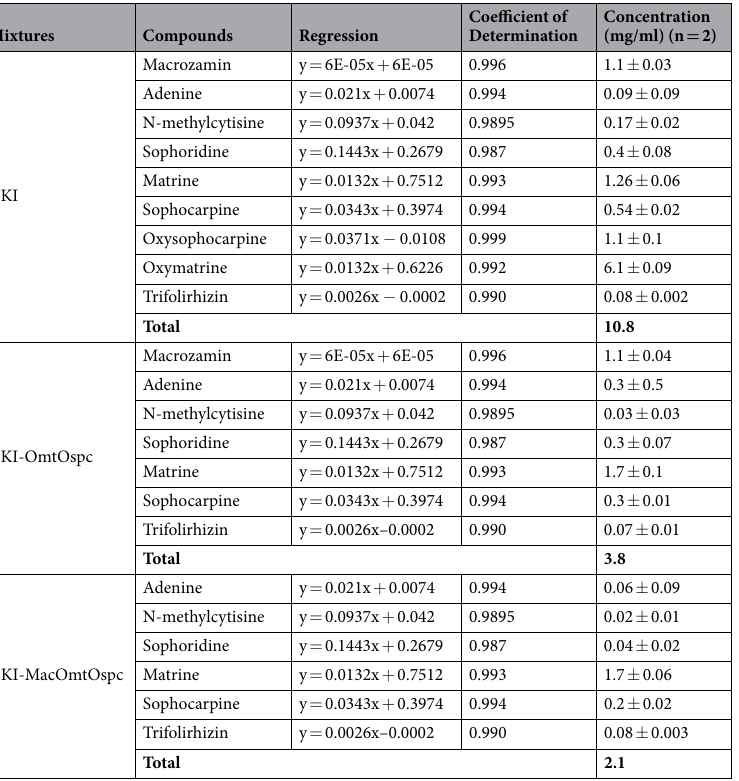
Table 2. Concentration of nine major compounds in CKI (Batch No: 20170322), remaining major compounds in CKI-OmtOspc, and remaining major compounds in CKI-MacOmtOspc. * Total alkaloid content in CKI = 26.5 mg/ml based on manufacturer’s